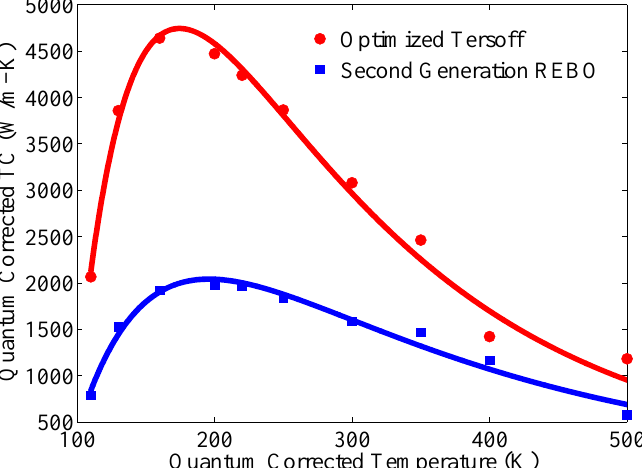
Figure 6. Quantum corrected thermal conductivity (TC) of GNR (10 nm length, 1 nm width) as a function of temperature using optimized Tersoff and 2nd generation REBO potentials.